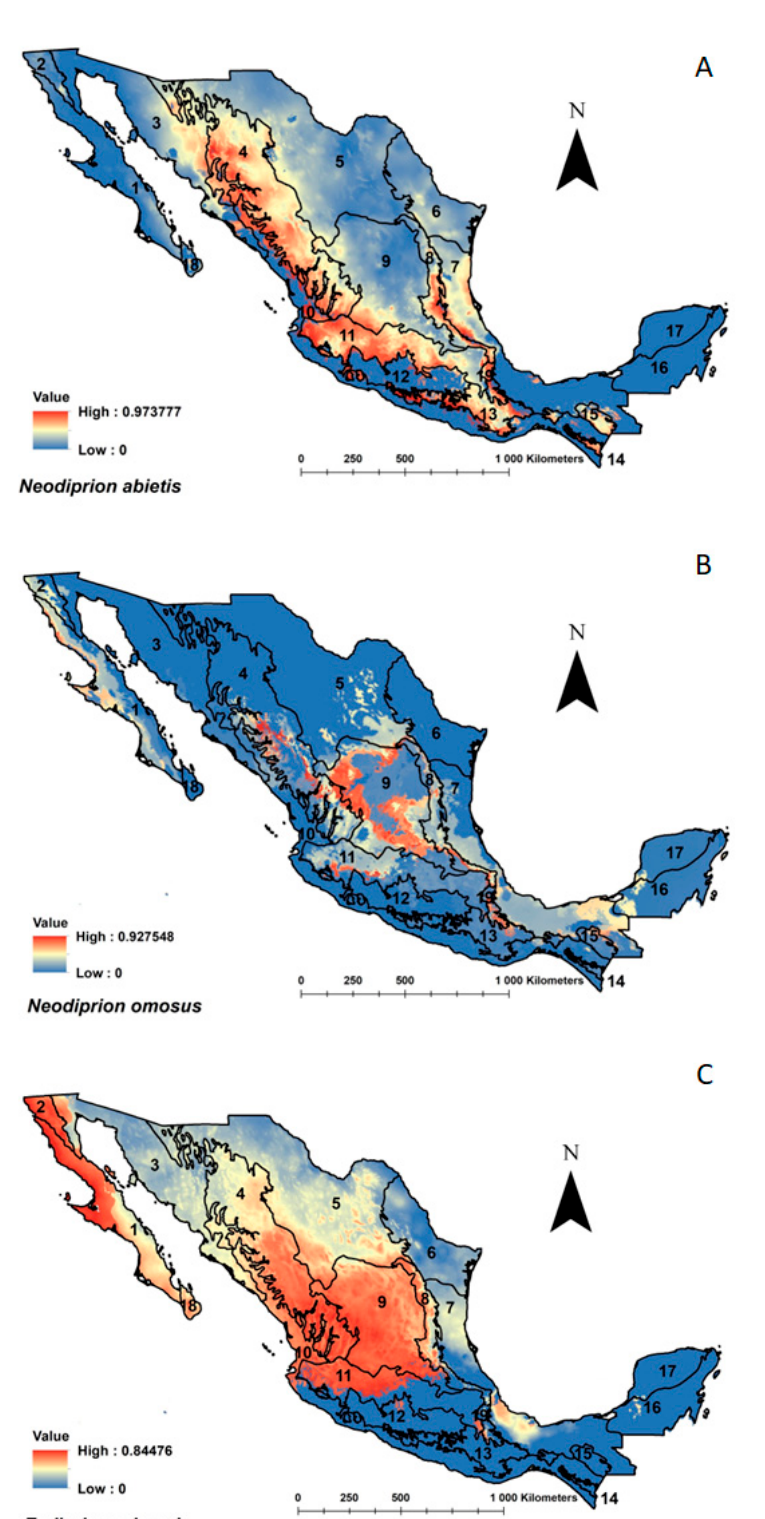
Figure 1. Ecological niche model of three species of sawflies (Hymenoptera: Diprionidae), projected according to the Mexican biogeographic provinces [53]. ( A ) Neodriprion abietis , ( B ) N. omosus and ( C ) Zadiprion rohweri ; 1. Baja California, 2. California, 3. Sonoran, 4. Sierra Madre Occidental, 5. Altiplano Norte, 6. Tamaulipeca, 7. Gulf of Mexico, 8. Sierra Madre Oriental, 9. Altiplano Sur, 10. Pacific Coast, 11. Volcanic Axis, 12. Balsas Depression, 13. Sierra Madre del Sur, 14. Soconusco, 15. Los Altos de Chiapas, 16. Pet é n, 17. Yucat á n, 18. Del Cabo, 19.